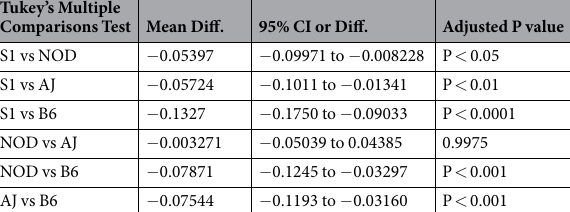
Tukey’s Multiple Comparisons Test Mean Diff.